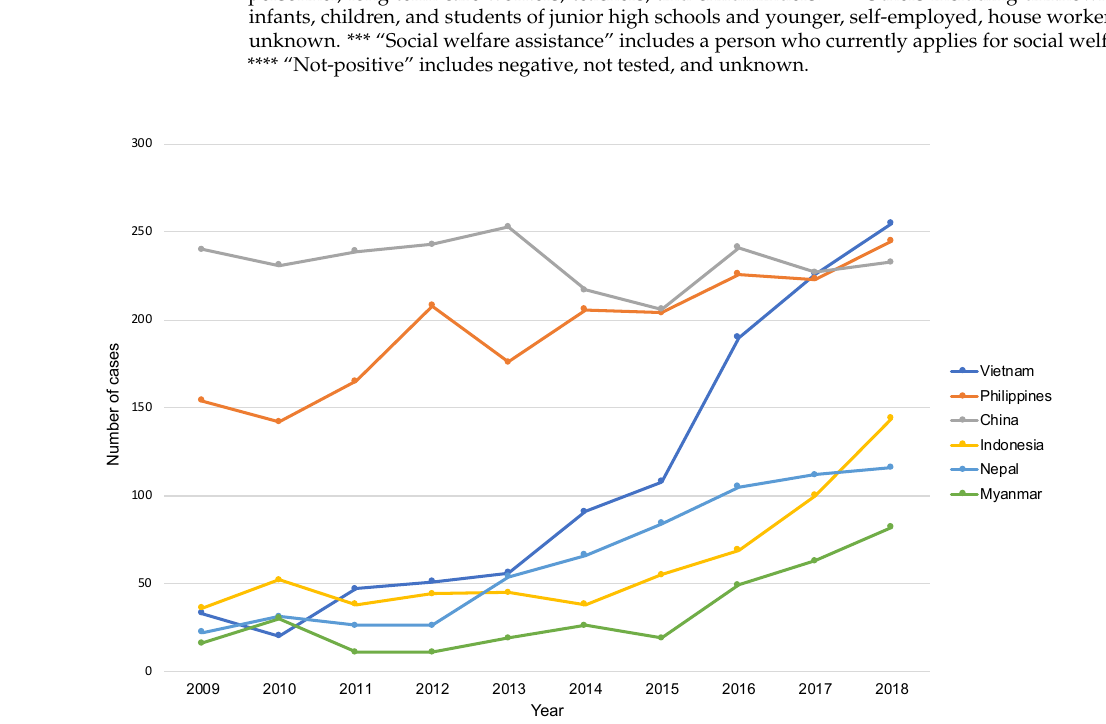
Figure 1. The number of overseas-born patients with pulmonary tuberculosis by selected countries of birth in 2009–2018.